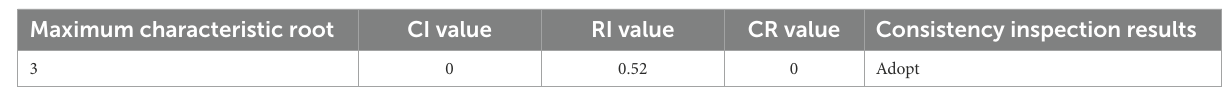
TABLE 9 Random consistency test of the first layer.